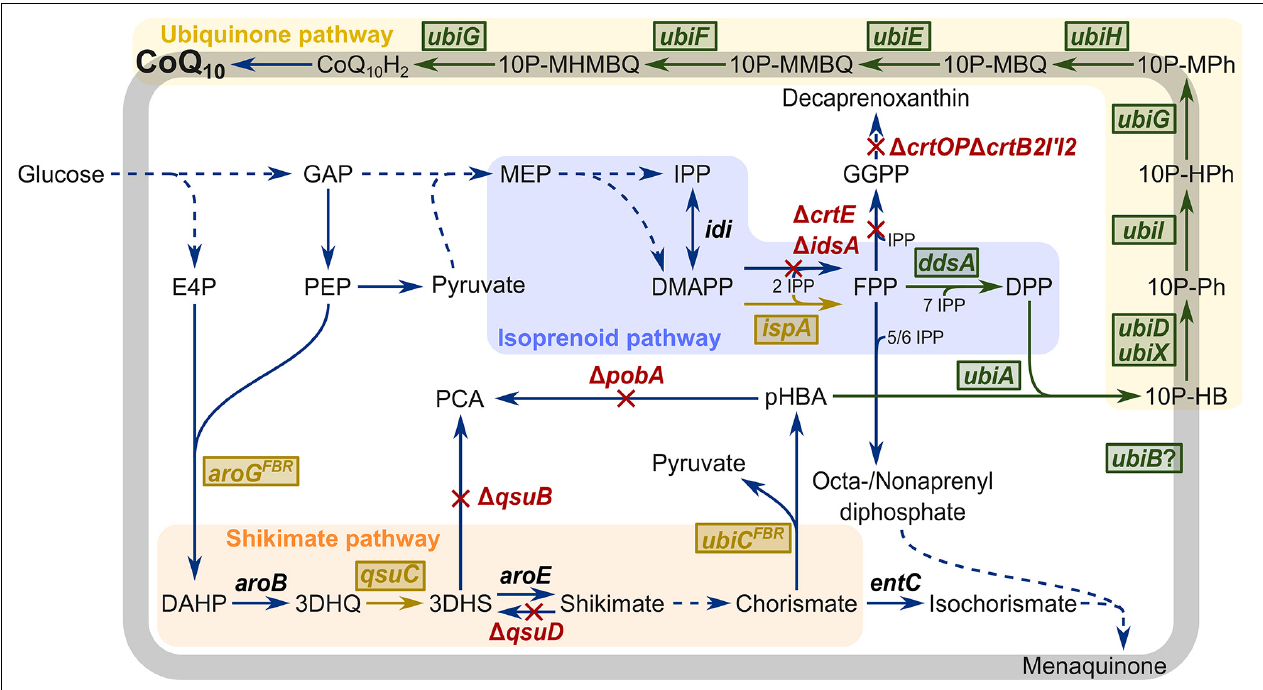
FIGURE 1 | Schematic overview of metabolic engineering of C. glutamicum for CoQ10 production. Heterologous plasmid-driven expression of genes is visualized in green boxes. Chromosomal overexpression of native and heterologous genes is visualized in yellow boxes. Deletion of genes is visualized in red. E4P, erythrose 4-phosphate; DAHP, 3-deoxy- D -arabinoheptulosonate 7-phosphate; 3DHQ, 3-dehydroquinate; 3DHS, 3-dehydroshikimic acid; PCA, protocatechuic acid; pHBA, para -hydroxybenzoate; GAP, glyceraldehyde 3-phosphate; PEP, phosphoenolpyruvate; MEP, 2-C-methylerythritol 4-phosphate; IPP, isopentenyl diphosphate; DMAPP, dimethylallyl diphosphate; GPP, geranyl diphosphate; FPP, farnesyl diphosphate; GGPP, geranylgeranyl diphosphate; DPP, decaprenyl diphosphate, 10P-HB, 3-decaprenyl-4-hydroxybenzoate; 10P-Ph, 2-decaprenylphenol; 10P-HPh, 2-decaprenyl-6-hydroxyphenol; 10P-MPh,